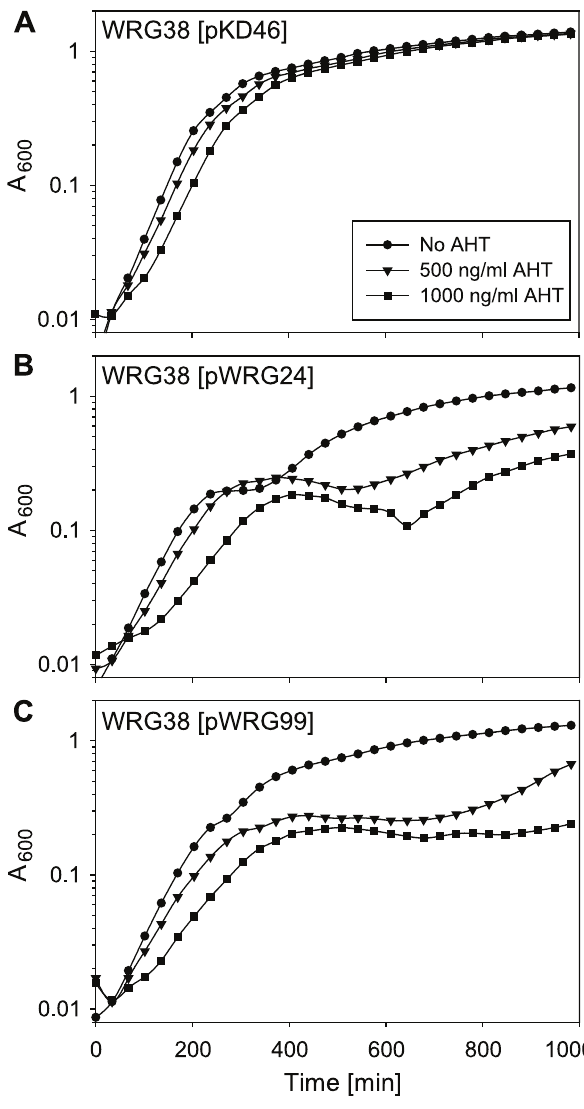
Figure 2. Growth of WRG38 ( phoQ 150:: cat I- Sce I) harboring both variants of pKD46-I- Sce I or pKD46 without and with addition of AHT. Depicted are growth curves of strain WRG38 harboring pKD46 (A), pKD46 with tetracycline-inducible I- Sce I cassette in orientation one (5’- . 3’: tetR -I- Sce I, pWRG24) (B) or in orientation two (5’- . 3’: I- Sce I- tetR , pWRG99) (C). Overnight cultures were adjusted to OD 600 = 0.01 in LB with 50 m g/ml carbenicillin (circles), further supplemented with 500 ng/ml (triangles) or 1000 ng/ml